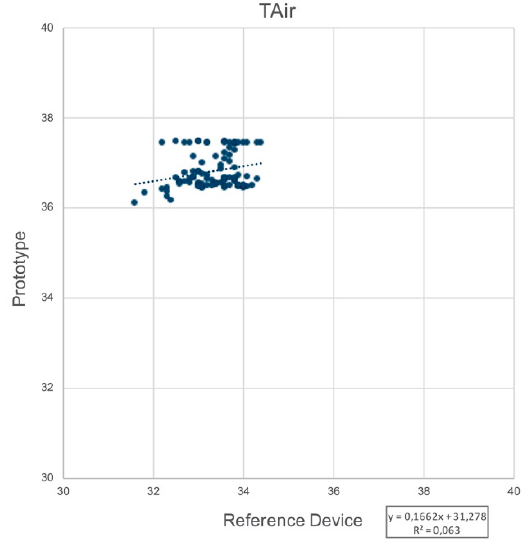
ISPRS Int. J. Geo-Inf. 2019 , 8 , 76 Figure 13. Validation graph for air temperature. Figure 13. Validation graph for air temperature.